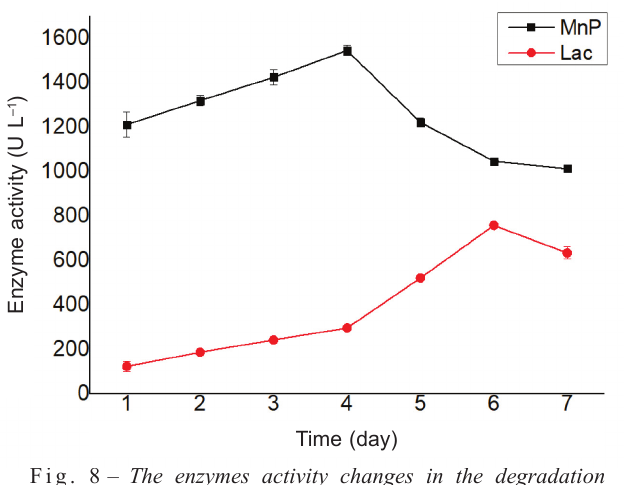
Time Fig. 8 – The enzymes activity changes in the degradation process